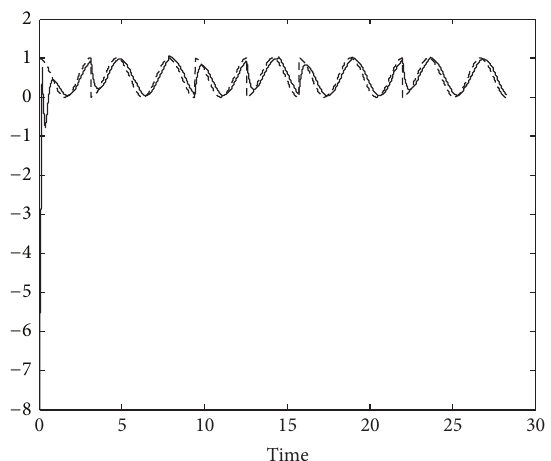
Figure 7: Actual carrier signal 𝑎 (dashed line) and decrypted carrier signal ̂𝑎 (solid line) when 𝑟 = 5 .